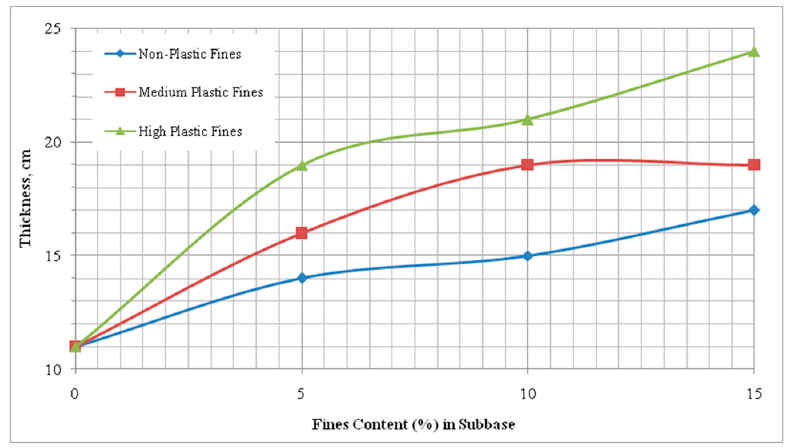
Figure 9. Base thickness with the use of composite samples (gradation C).